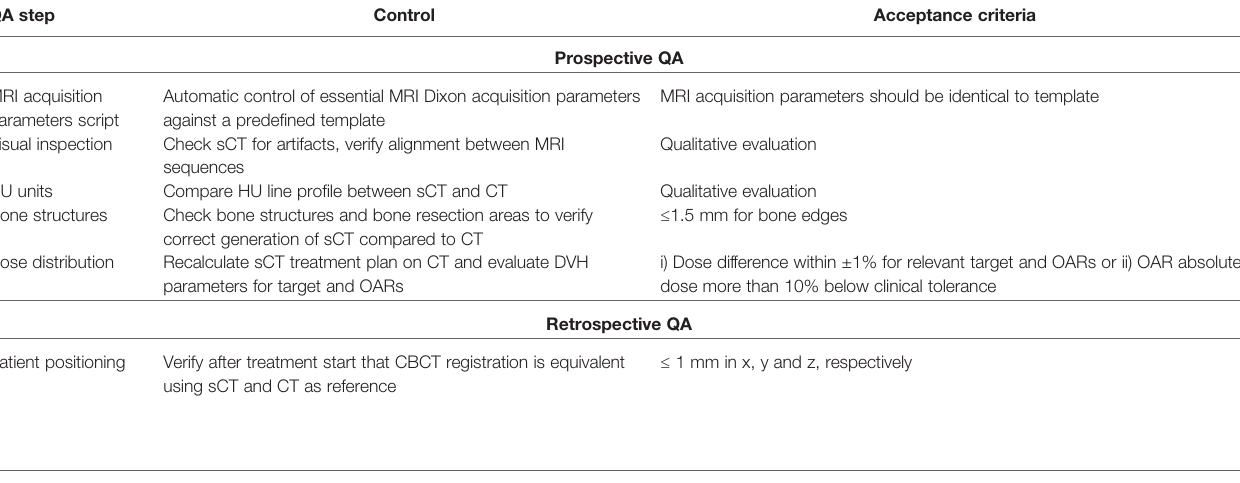
TABLE 2 | Summary of the QA steps introduced for MRI-only implementation, including both prospective and retrospective